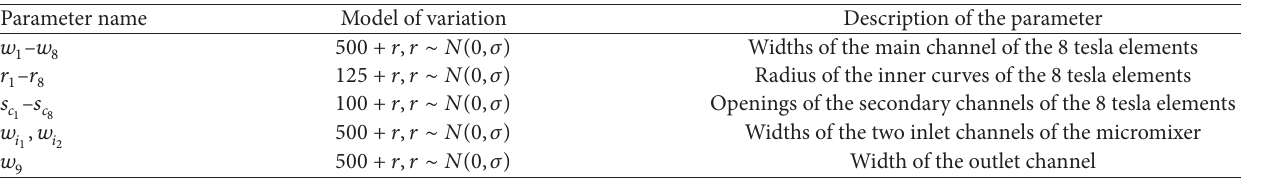
Table3:Variationmodelsofthegeometricalparametersofthemicromixerwith8connectedteslaelements(foreachparameter, 𝜎 iscalculated such that the variation of the parameter is up to 10% from its nominal value).